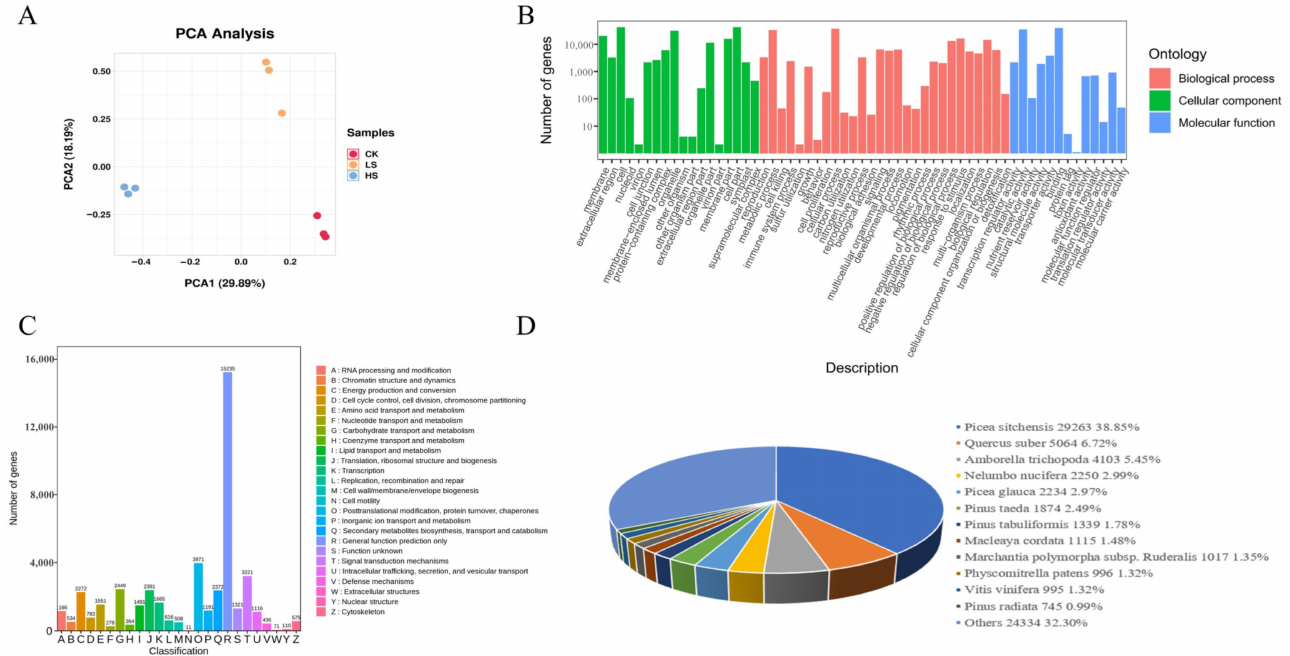
Figure 4. Functional annotation of assembly unigenes in P. koraiensis under light stress. ( A ) PCA score plot of expression profiles from different samples. CK: control. LS: light shade. HS: heavy shade. ( B ) GO classifications of assembly unigenes. ( C ) KOG functional classification of assembly unigenes. ( D ) Similarity of P. koraiensis sequences with other species in